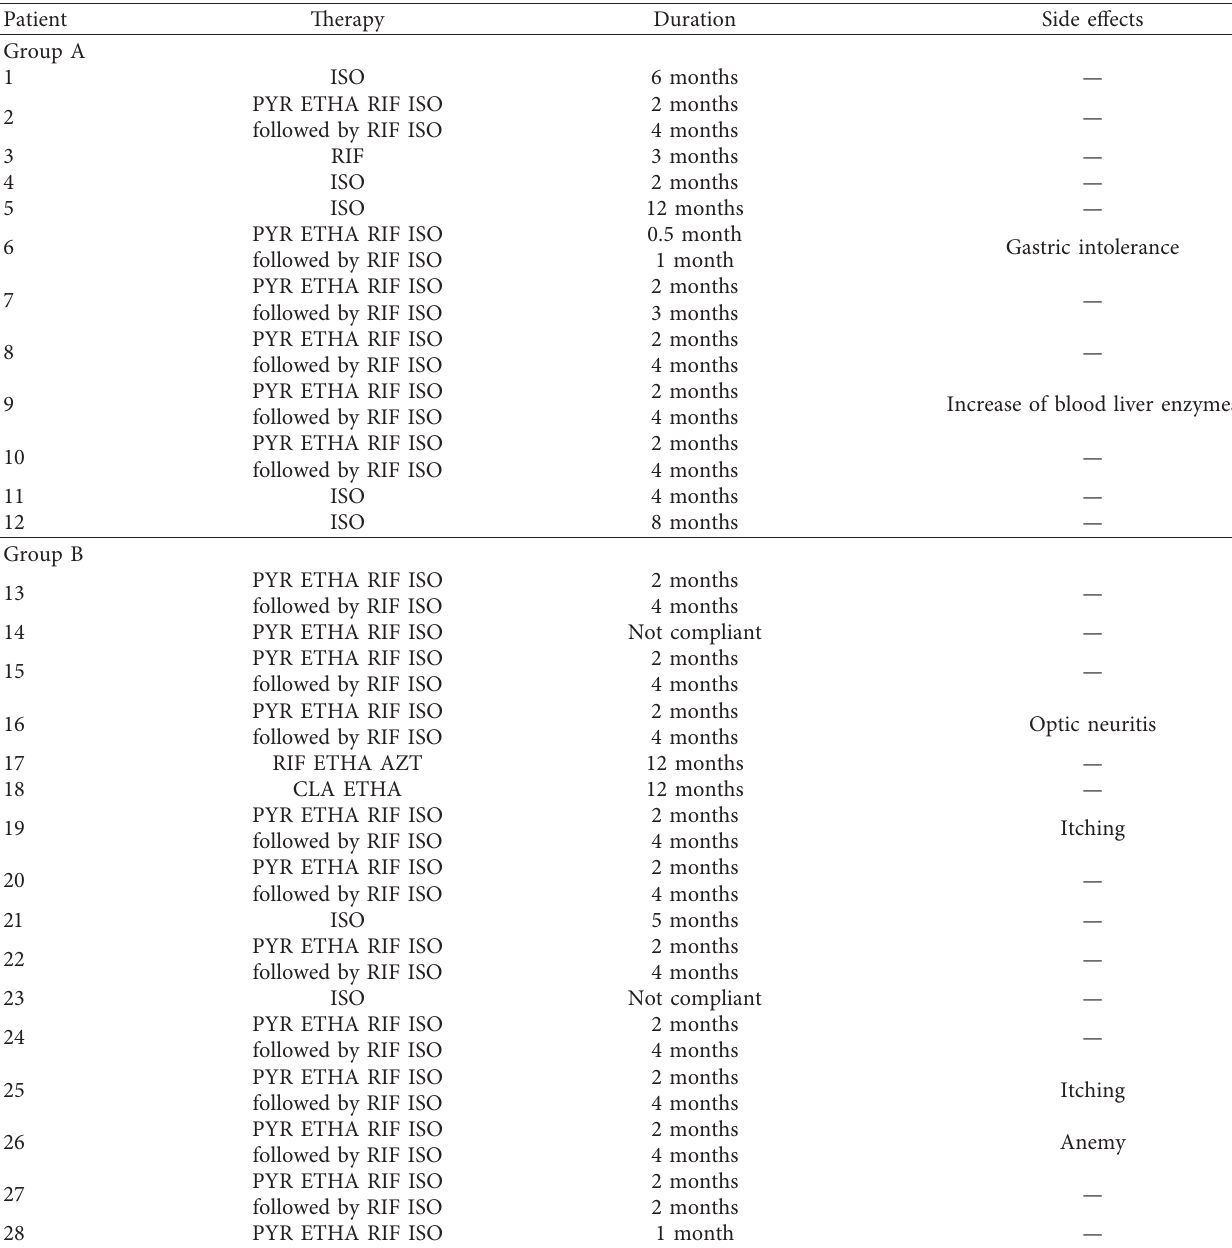
Table 2: Antitubercular treatment in the two groups. (PYR � Pyrazinamide; ETHA � Ethambutol; RIF � Rifampicin; ISO � Isoniazid; and CLA �